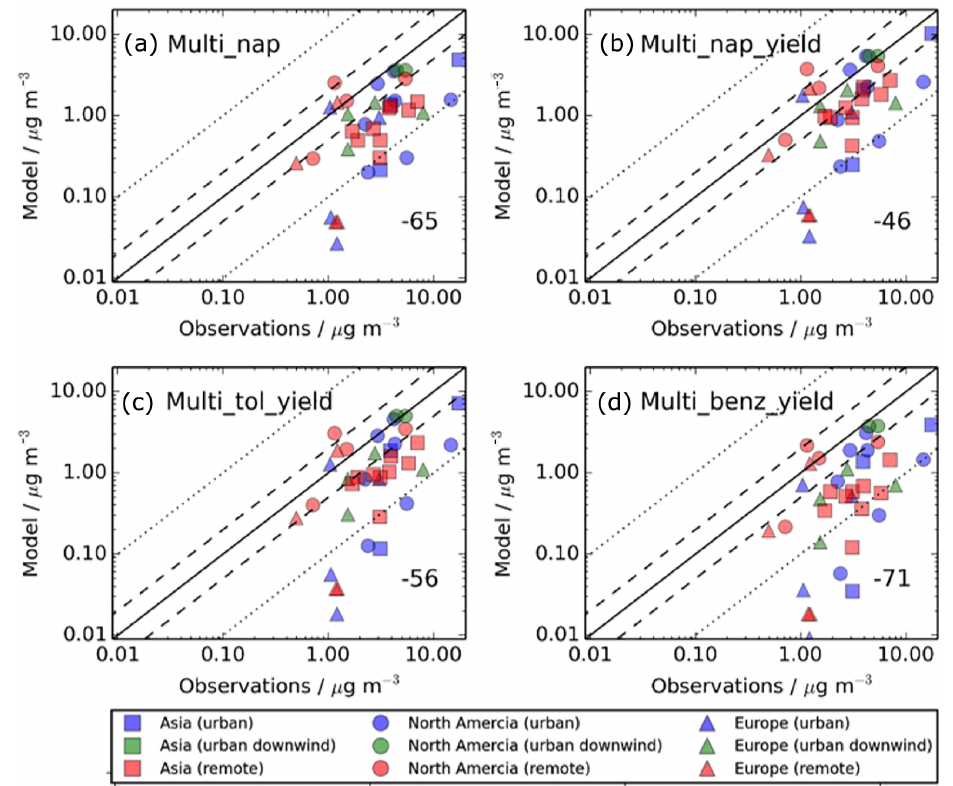
Figure 13. Simulated versus observed SOA concentrations (µgm − 3 ) for (a) Multi_nap, (b) Multi_nap_yield, (c) Multi_tol_yield, and (d) Multi_benz_yield simulations, described in Table 3. Observations for the time period 2000–2010 are classified by site type – urban (blue), urban downwind (green), or remote (red) – and continent – Asia (squares), North America (circles) and Europe (triangles). Observed oxygenated OA is assumed to be comparable to simulated SOA. The 1 : 1 (solid), 1 : 2 and 2 : 1 (dashed), and 1 : 10 and 10 : 1 (dotted) lines are indicated. Numerical values in the bottom right of each panel indicate the normalised mean bias